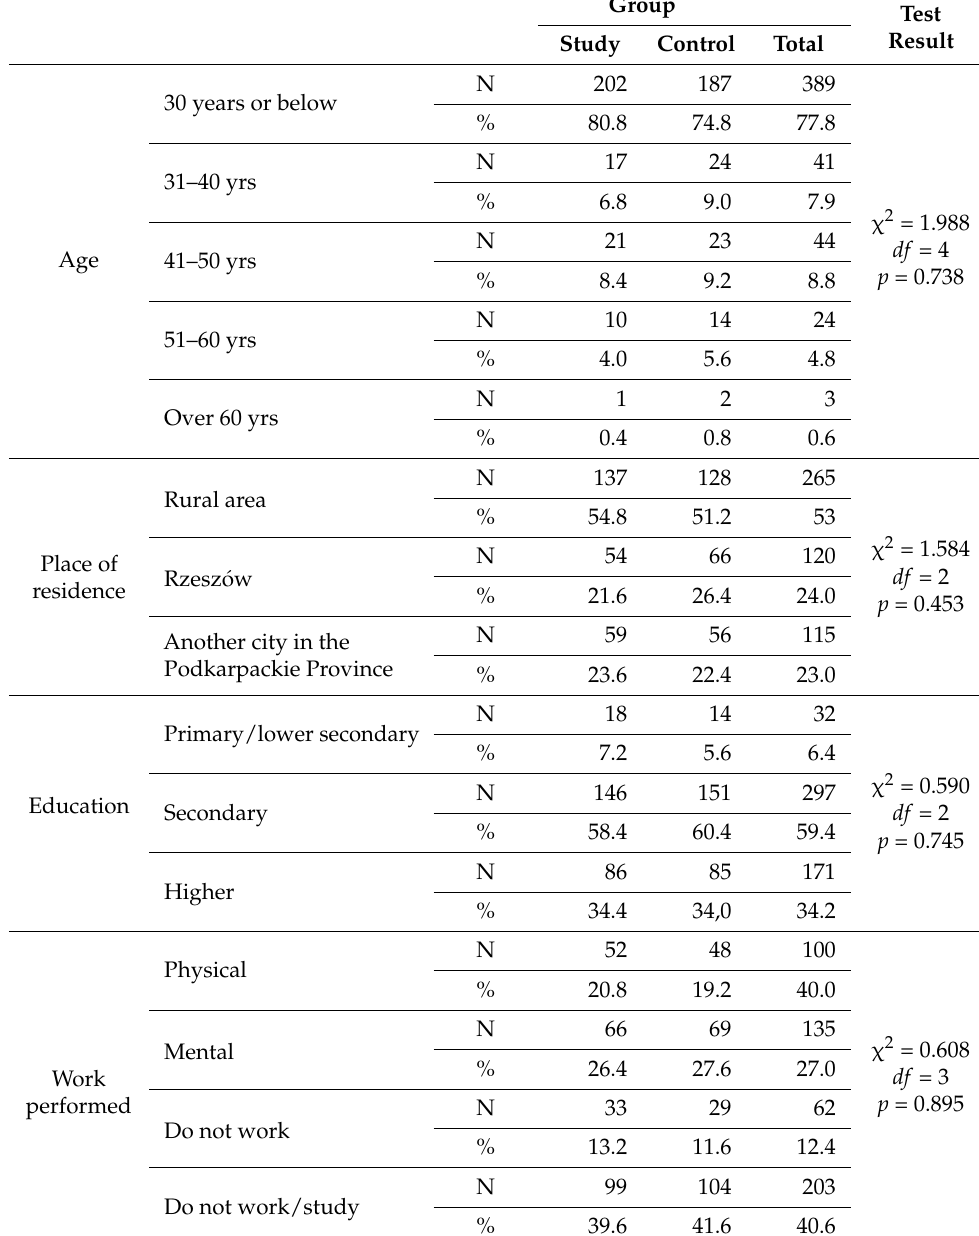
Table 1. Characteristics of the studied